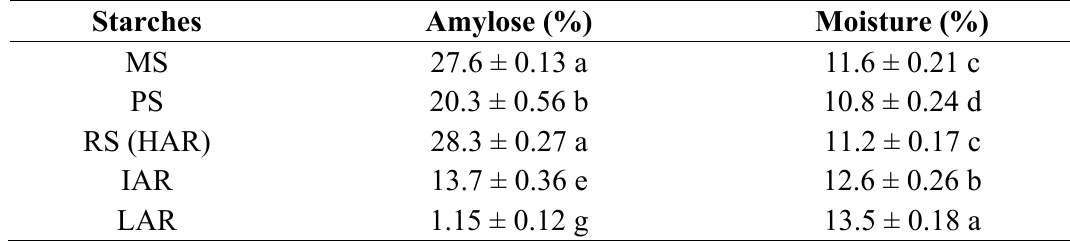
Data are expressed as mean ± standard deviation. Values followed by the same letter in the same column are not significantly different ( p < 0.05). MS, maize starch; PS, potato starch; RS (HAR), rice starch (high amylose rice starch); IAR and LAR (intermediate and low amylose rice starch).